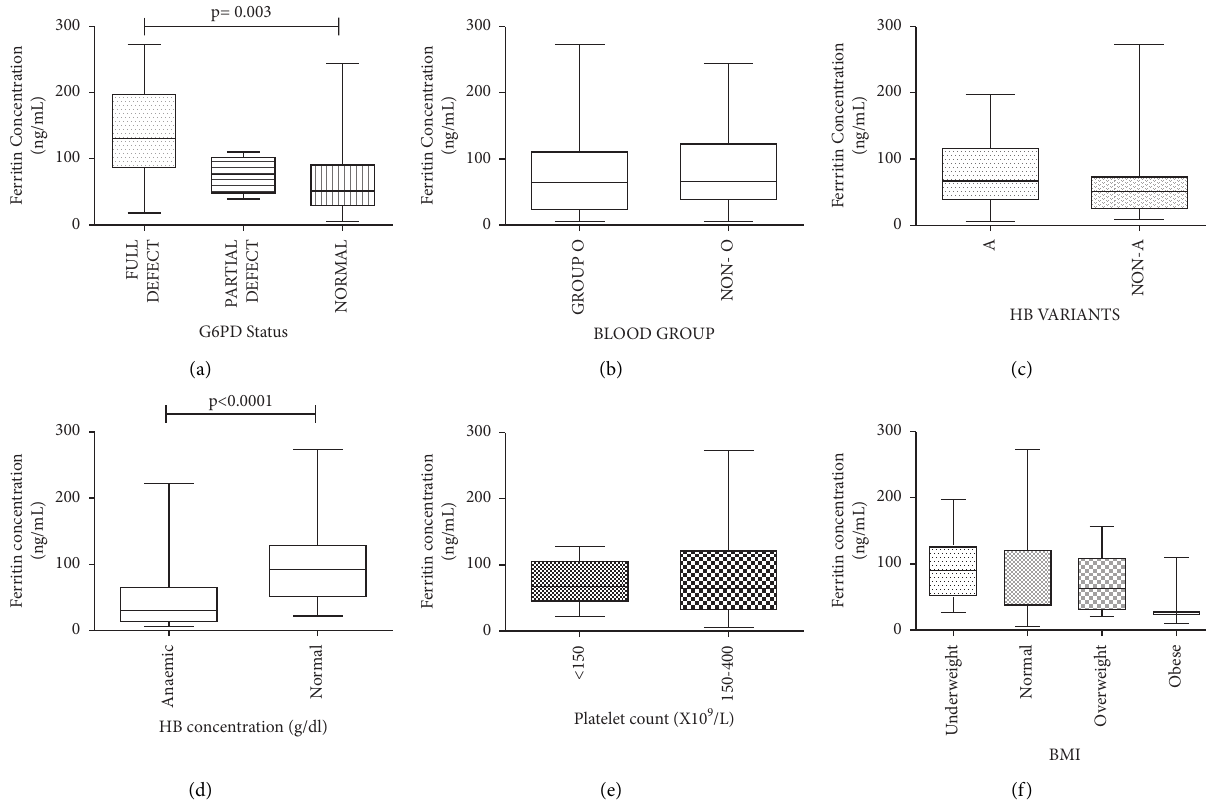
Figure 3: Serum ferritin levels of participants stratified according to BMI and haematological parameters. (a) The distribution of the ferritin levels of participants across their G6PD status (Kruskal–Wallis with Dunn’s multiple comparison test was performed). (b) The distribution of the ferritin levels of participants across their blood groups. (c) The distribution of the ferritin levels of participants across their haemoglobin types. (d) The distribution of the haemoglobin concentration of the participants across the different groups of ferritin concentration (the Mann–Whitney test was used). (e) The distribution of the platelet count of the participants across the different groups of ferritin concentration. (f) The distribution of the body mass index of the participants across the different groups of ferritin concentration. BMI: body mass index; PLT: platelet; and HB: haemoglobin. Table 2: The relationship between ferritin, gender of participants, and inherited red cell parameters. Ferritin p value Iron depletion Iron deficiency